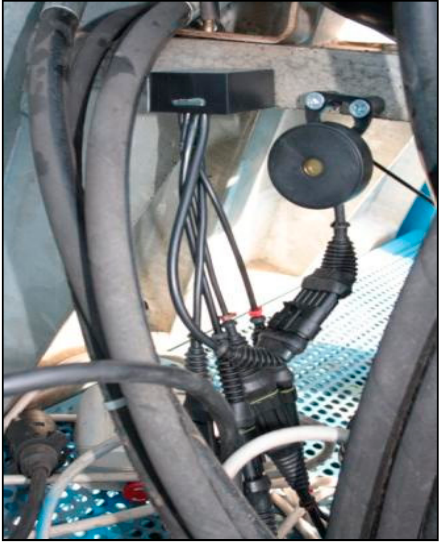
Figure 5. Microprocessor and beeper.